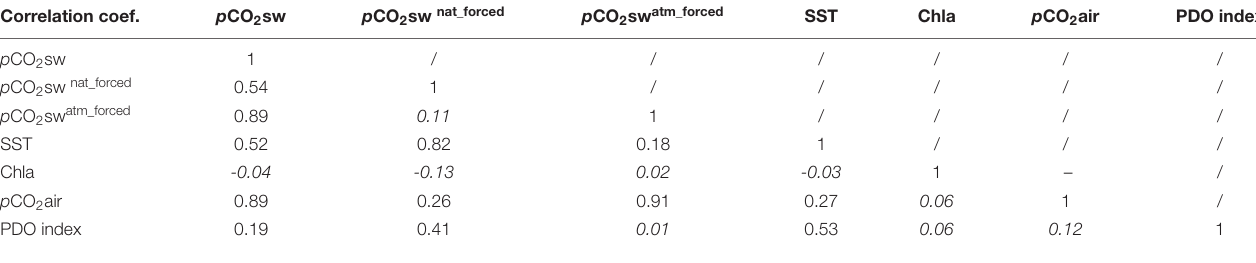
TABLE 1 | Correlation coefficients among the monthly anomalies of p CO 2 sw, p CO 2 sw nat_forced , p CO 2 sw atm_forced , SST, Chla, p CO 2 air, and PDO index, with insignificant correlation (i.e., p > 0.05) annotated in italic. Correlation